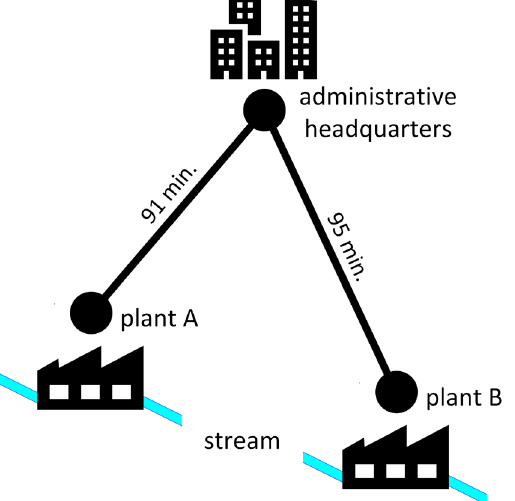
Figure 5. Travel time between the administrative headquarters and the plants.